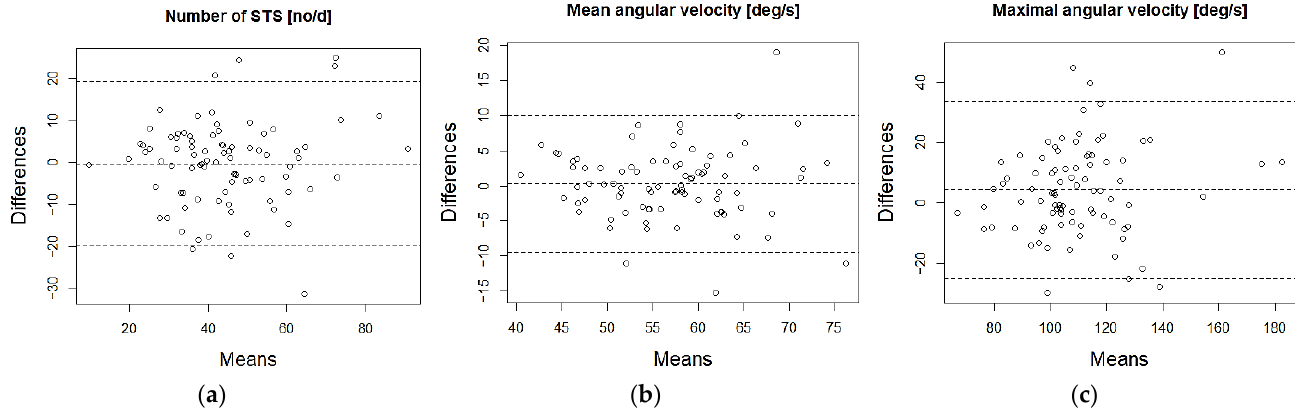
Figure 3. Bland–Altman plots: ( a ) number of STS, ( b ) mean angular velocity and ( c ) maximal angular velocity ( n = 86).